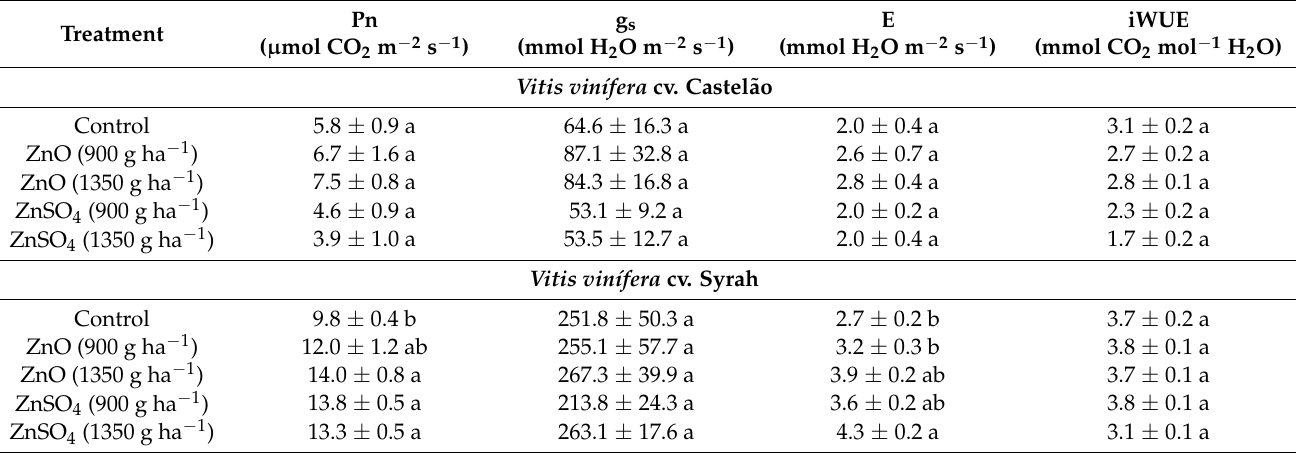
Table 2. Average ± S.E. of leaf gas exchange parameters, net photosynthesis (Pn), stomatal conduc- tance to water vapor (gs), as well as variation in the instantaneous water use efficiency (iWUE = Pn/E) in leaves of Vitis vinifera , varieties Castel ã o and Syrah, after the 4th leaf spraying on 21 August with ZnO and ZnSO 4 at different concentrations. For each parameter and variety, the average value ±